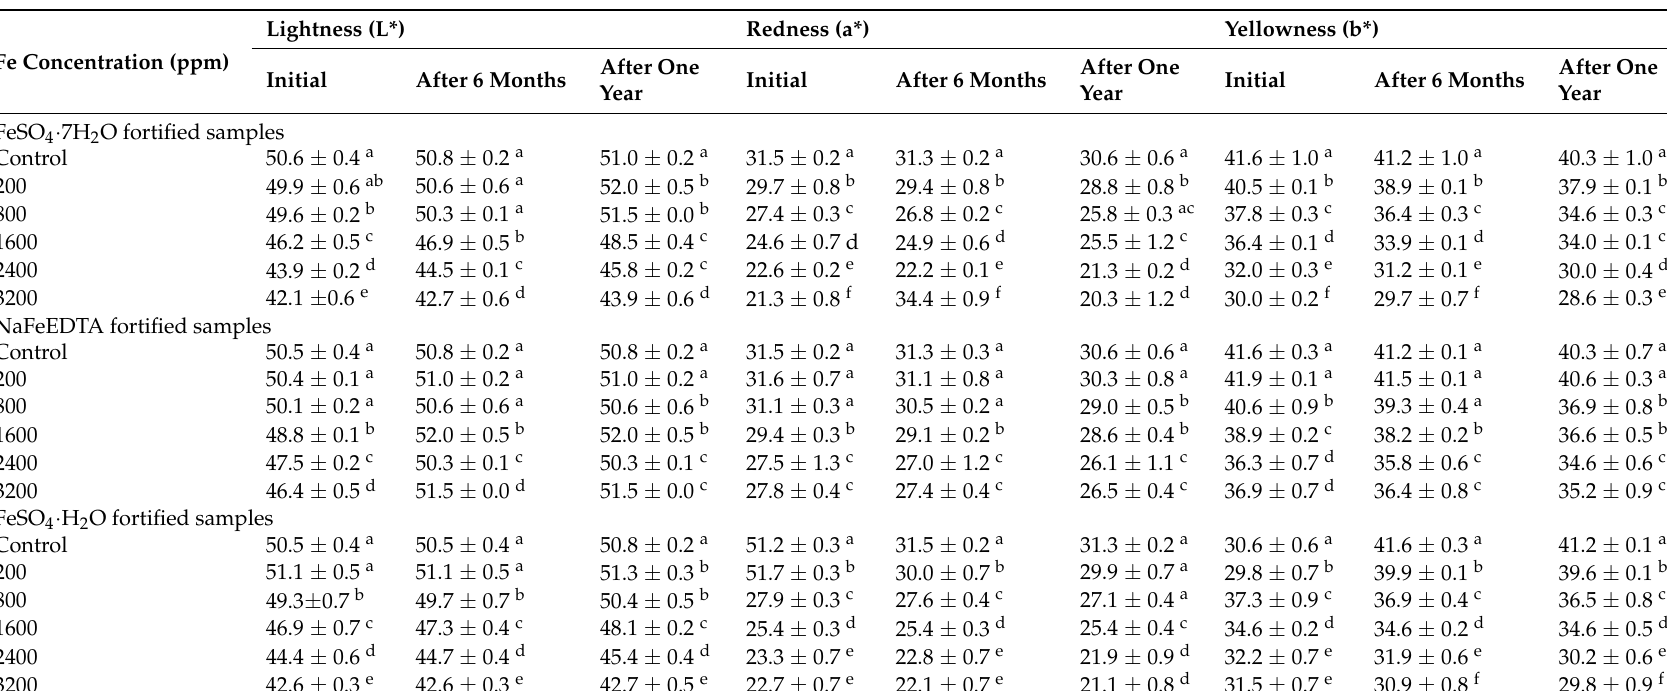
a Mean ± SD. Mean scores for lightness (L*), redness (a*) and yellowness (b*) score followed by different letters within columns are significantly different ( p <